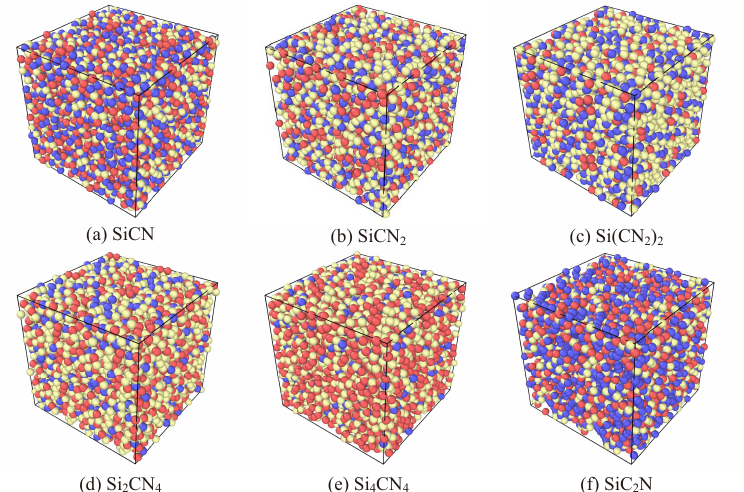
Figure 1. Schematic representation of a-SiC x N y with different atomic ratios (Color scheme—Si: red; C: blue; and N: